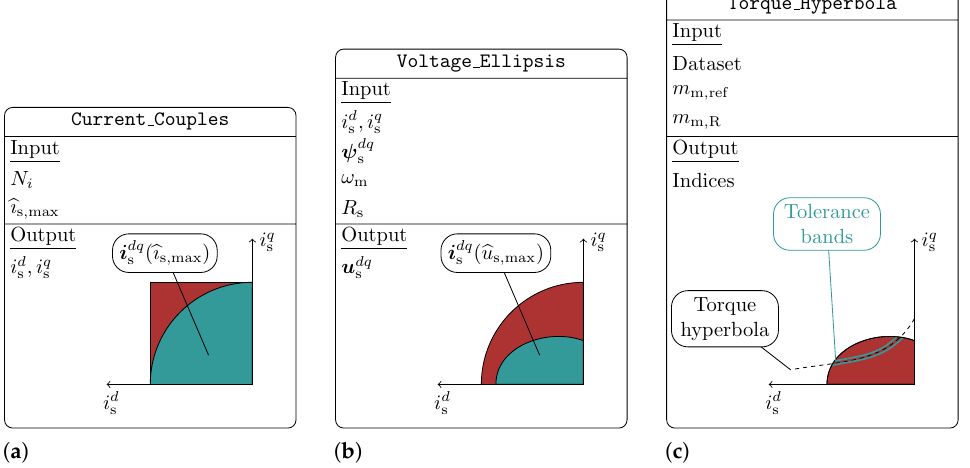
Figure 12. Illustration of subroutines Current_Couples , Voltage_Ellipsis and Torque_Hyperbola . ( a ) Current constraint. ( b ) Voltage constraint. ( c ) Reference